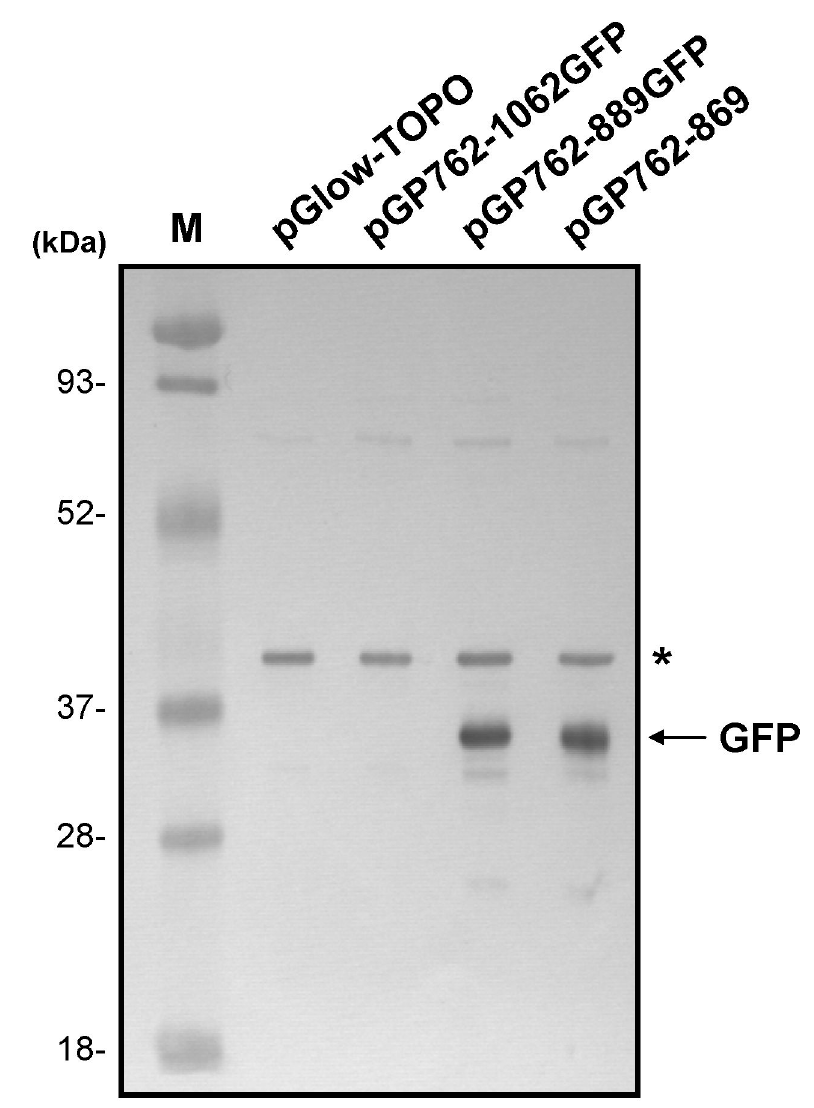
Figure 4. Translation of the putative downstream ORFs as detected by western blot analysis. Total proteins from E. coli harboring various constructs (as indicated at the top) were separated by electrophoresis through a 12.5% polyacrylamide gel containing 1% SDS, transferred to a PVDF membrane, and probed with a GFP-specific antiserum. The relative molecular weight of the size marker (lane M) is shown on the left. The position of GFP is indicated on the right. A non-specific protein band is indicated by an asterisk. The expected molecular weight of the GFP-fusion protein expressed from pGP762-889GFP and the positive control from pGP762-869 are 28.96 kDa and 28.62 kDa respectively, as calculated from the amino acid